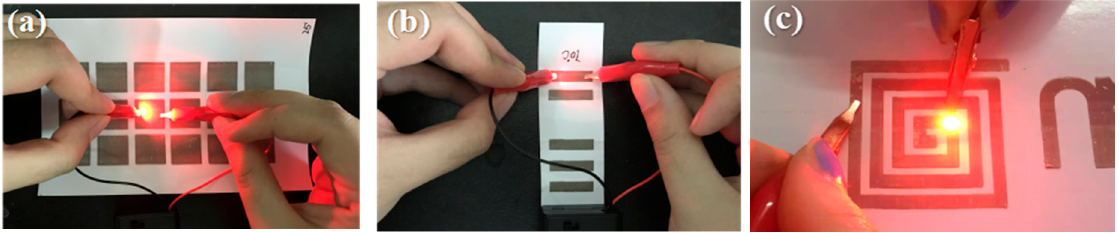
Figure 10. The simple conductivity test of printed Ag patterns: ( a ) Square; ( b ) Rectangle; ( c ) Spiral.